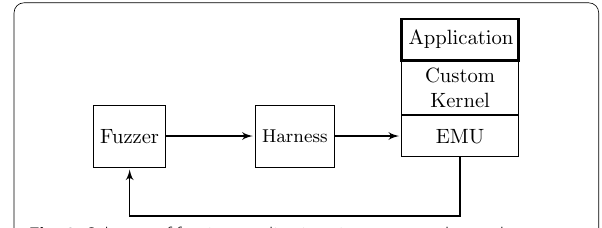
Fig. 3 Scheme of fuzzing applications in a user-mode